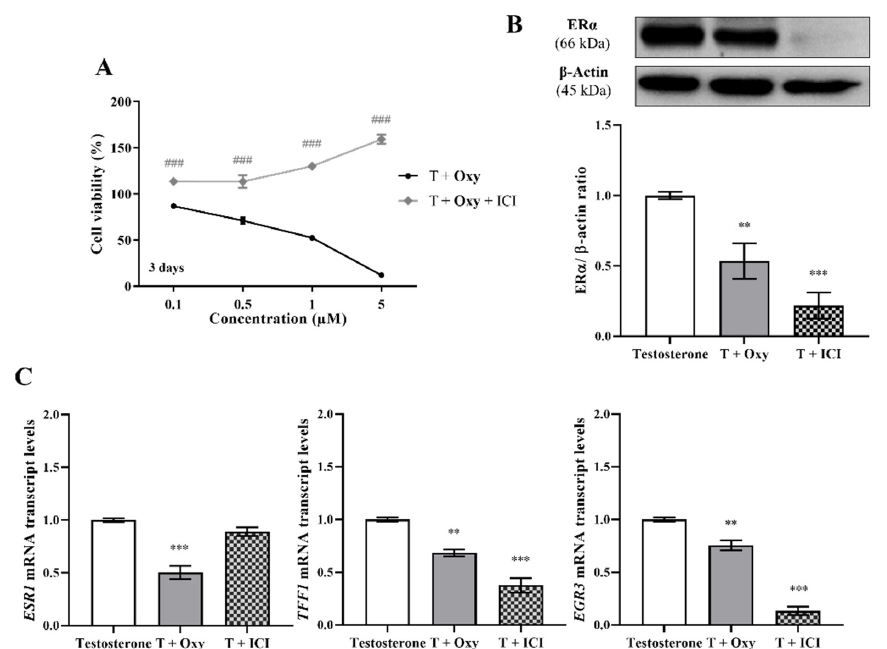
Figure 5. Involvement of ER α in the effects induced by Oxy on breast cancer cells. ( A ) Effects of Oxy (0.1–5 µ M) on viability of MCF-7aro cells stimulated with T (1 nM) and treated with or without ICI (100 nM), after 3 days. Effects of Oxy (1 µ M) on the expression levels of ( B ) ER α protein or on ( C ) mRNA transcript levels of ESR1, TFF1, EGR3 and PDZK1 genes, after 3 days. Cells without Oxy treatment were considered as control, while cells treated with ICI (100 nM) were designated as negative control. β -actin was used as a loading control, with the densitometry results presented as ER α / β -actin ratio. The protein expression obtained for treated cells was normalized in relation to protein expression of control (1 nM T). To quantify the mRNA transcript levels of ESR1, TFF1, EGR3 and PDZK1 genes, the housekeeping gene TUBA1A was used. The mRNA transcript levels of treated cells were normalized in relation to mRNA transcript levels of control (Testosterone). Results are presented as the mean ± SEM of at least three independent experiments, each performed in triplicate. Significant differences between cells treated with Oxy with or without ICI are denoted by ### ( p < 0.001), while between the control and Oxy - or ICI-treated cells are shown by ** ( p < 0.01) and *** ( p < 0.001).